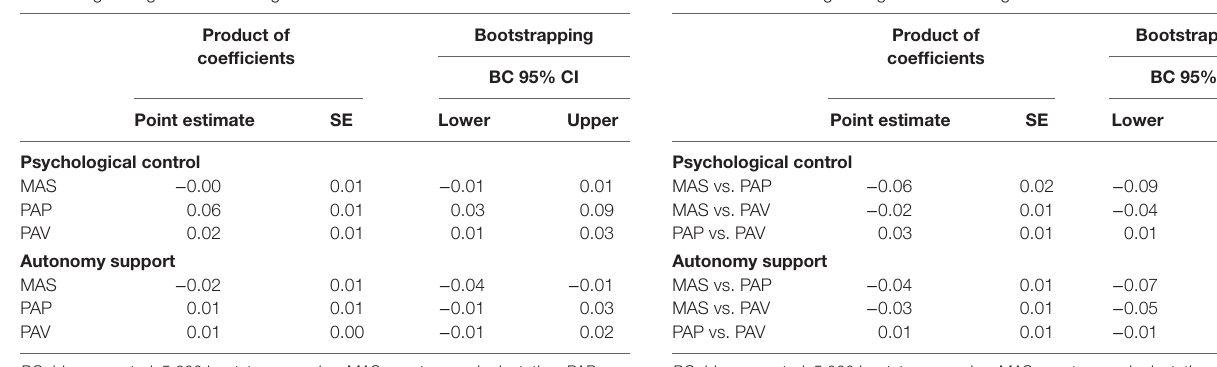
Table 4 | Contrasts of indirect effects from parenting on students’ maladaptive academic functioning through achievement goal orientations.